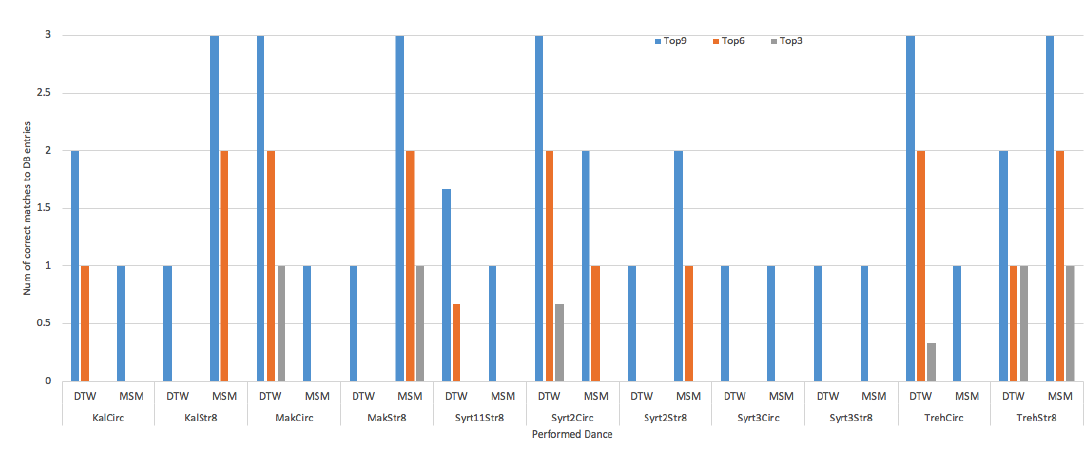
Figure 16. Performance illustration for the matching